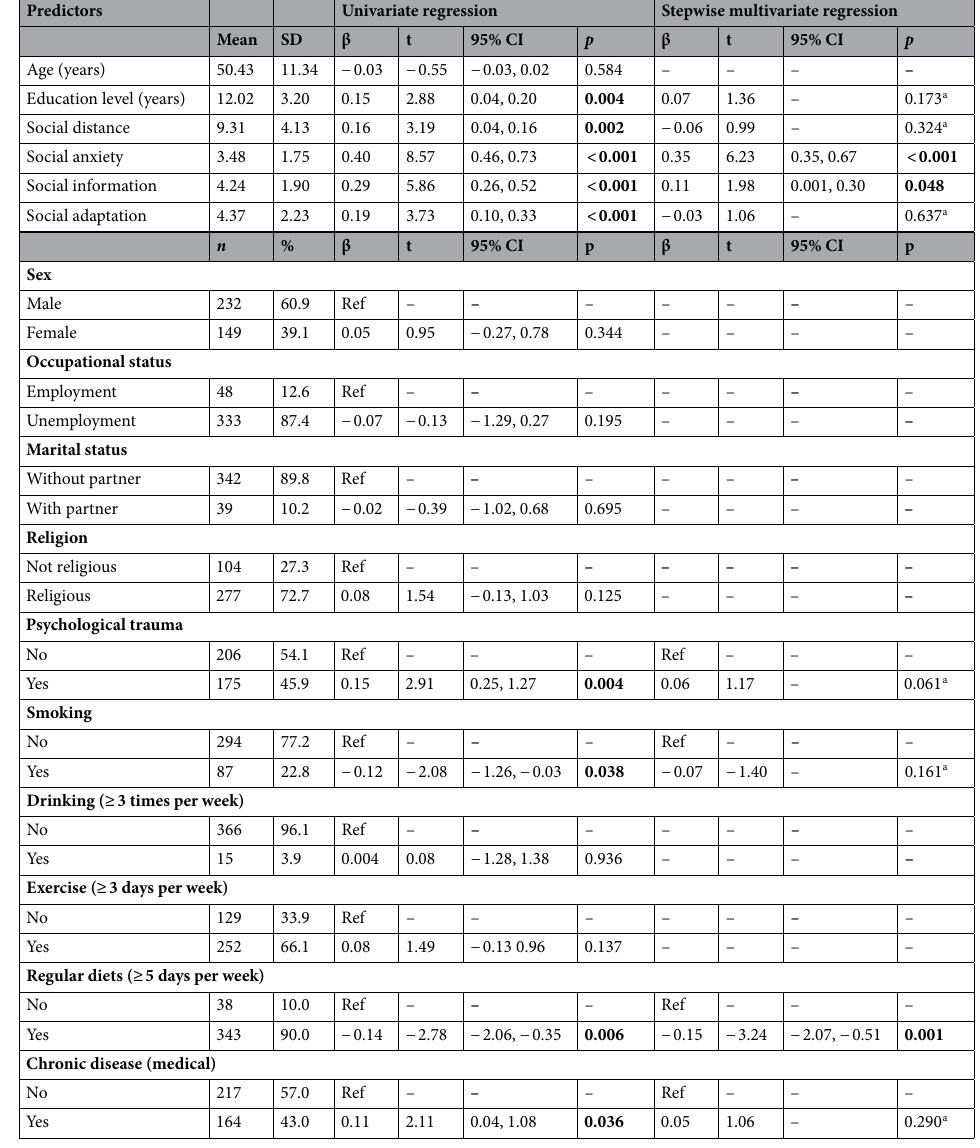
Table 2. Predictors for COVID-related psychological distress examined by univariate and stepwise multivariate linear regression (N = 381). β: standardized coefficients; t: T score; CI: Confidence interval; SD: Standard deviation; Bolds: p < 0.005; a : excluded from stepwise